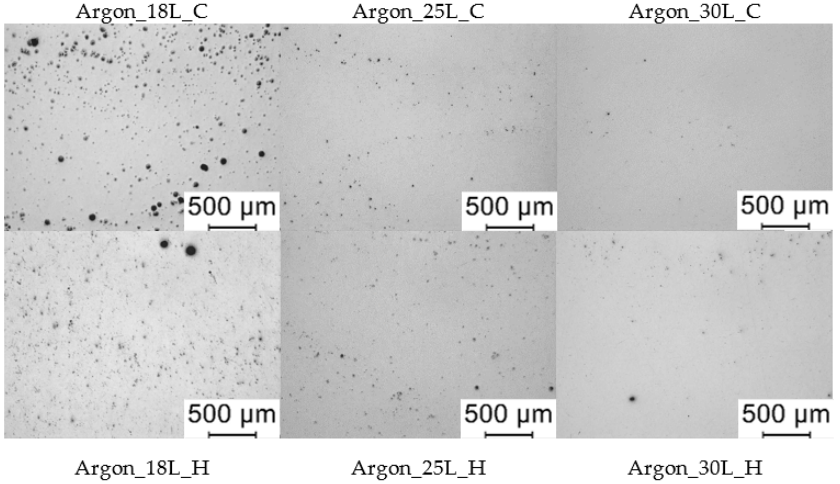
Figure 9. Porosity in AA5356 wire-arc additive manufacturing (WAAM) walls built with Argon Q1 shielding gas.